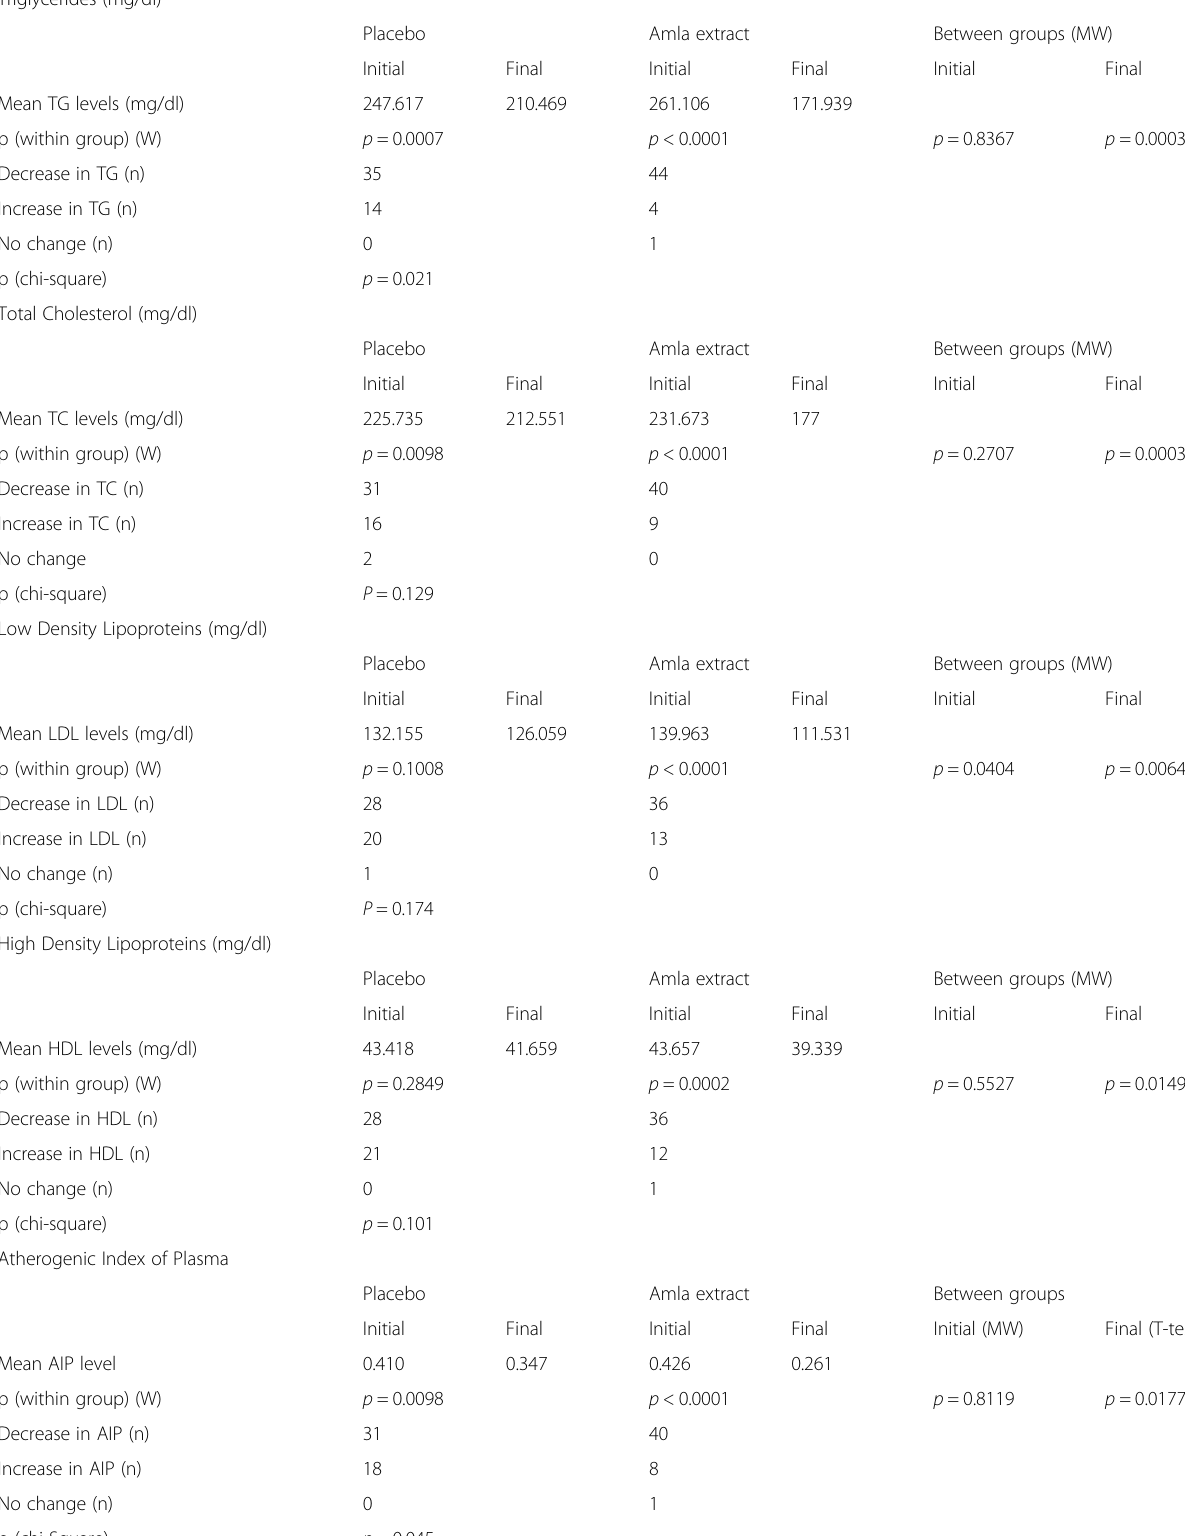
Table 2 Table with p values within the group (amla extract/placebo) and between groups Triglycerides